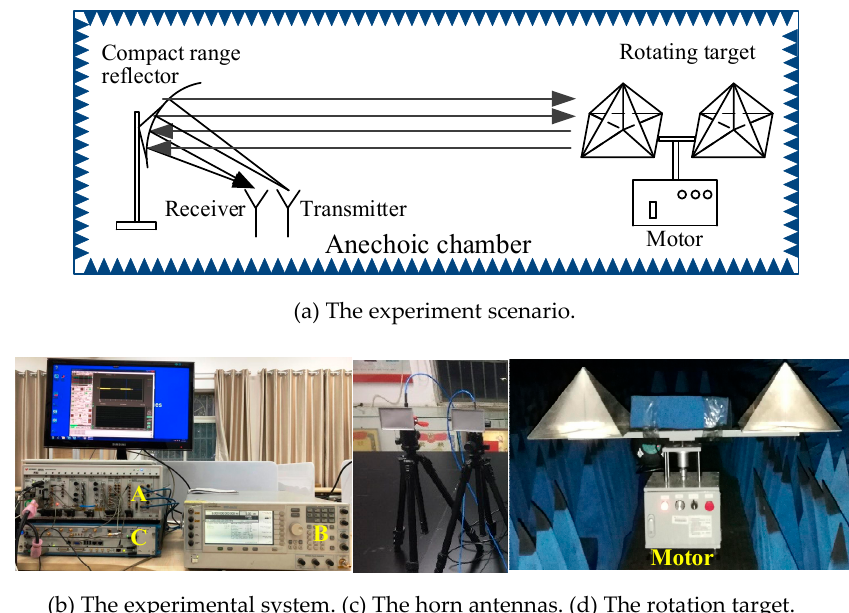
Figure 5. Experimental system and rotation target model. ( a ) The experiment scenario. ( b ) The experimental system. ( c ) The horn antennas. ( d ) The rotation target.